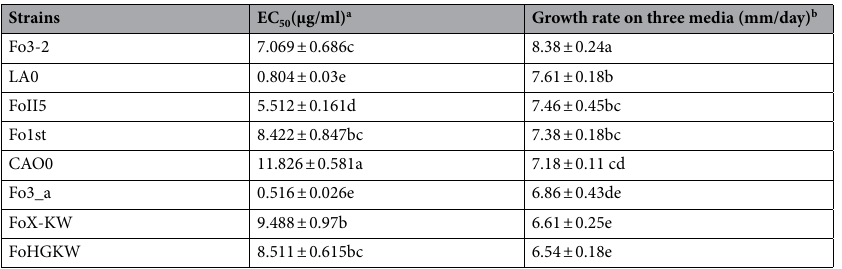
Table 1. Sensitivity of the Fusarium oxysporum isolates to phenamacril and growth rate. a EC 50 is the fungicide concentration resulting in 50% mycelial growth inhibition. Values are means ± standard deviation of three experiments, values in a column followed by the same letters are not significant difference at P = 0.05, Fisher’s LSD test. b Growth rate was measured after incubation for 7 days. Mean and standard deviation were calculated from three replicates. The same letter indicated there was no significant difference. Different letters were used to mark statistically significant differences ( P =